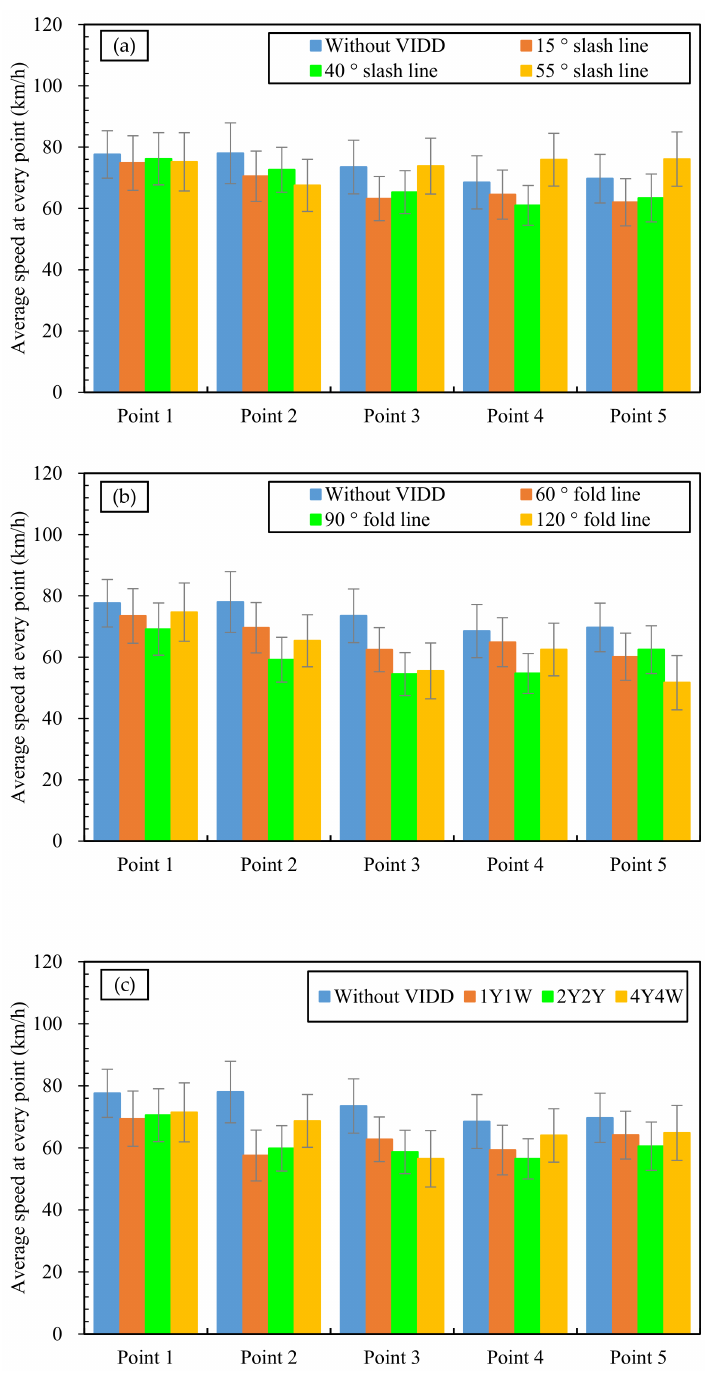
Figure 16. Average speeds at every point for vehicles controlled by different types of VIDD: ( a ) slash lines; ( b ) fold lines; ( c ) alternating yellow and white